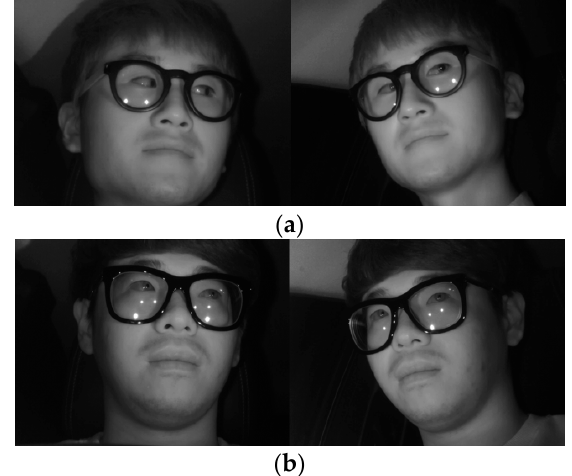
Figure 15. Incorrectly classified cases of frontal face image. ( a ) Right image selected; ( b ) Right image selected.